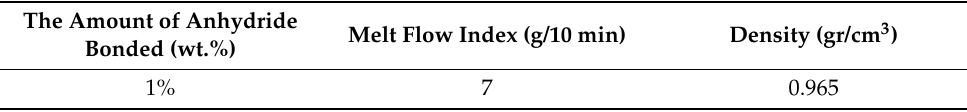
Table 3. Specifications of polyethylene bonded with maleic anhydride.